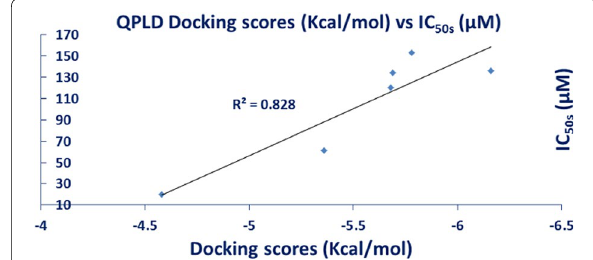
Fig. 4 The correlation between the QPLD docking scores and between IC 50 for the tested